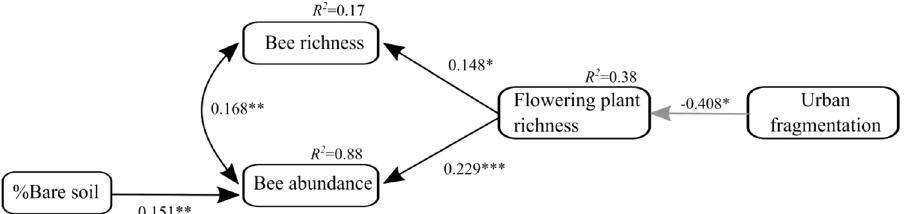
Figure 5. Final path model of local (patch) factors, landscape heterogeneity and their relationships with bee richness and abundance. Black solid arrows show positive and grey arrows negative direct effects as derived from the piecewise SEM analysis. Standardized path coefficients are reported next to the bold arrows and R 2 values (percentage of explained variation) are reported for all response variables. * P ≤ 0.05; ** P ≤ 0.01; *** P ≤